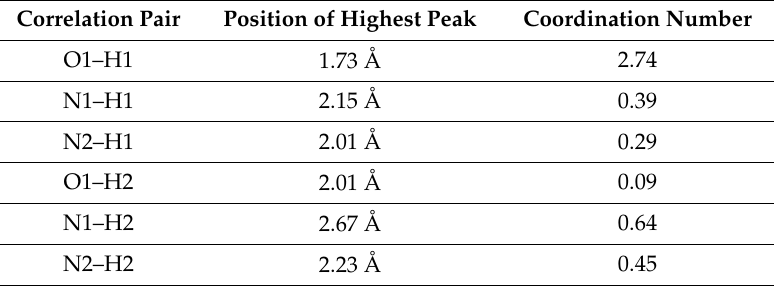
Table 1. The maxima of the radial distribution functions and the coordination numbers of the selected atom pairs. Correlation Pair Position of Highest Peak Coordination Number